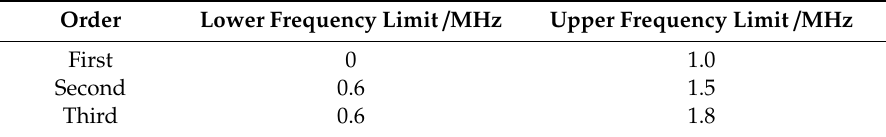
Figure 13. The first to third order modes included in the time-frequency joint spectrum of bar 04. Table 4. The frequency range of the first to third order modes of bar